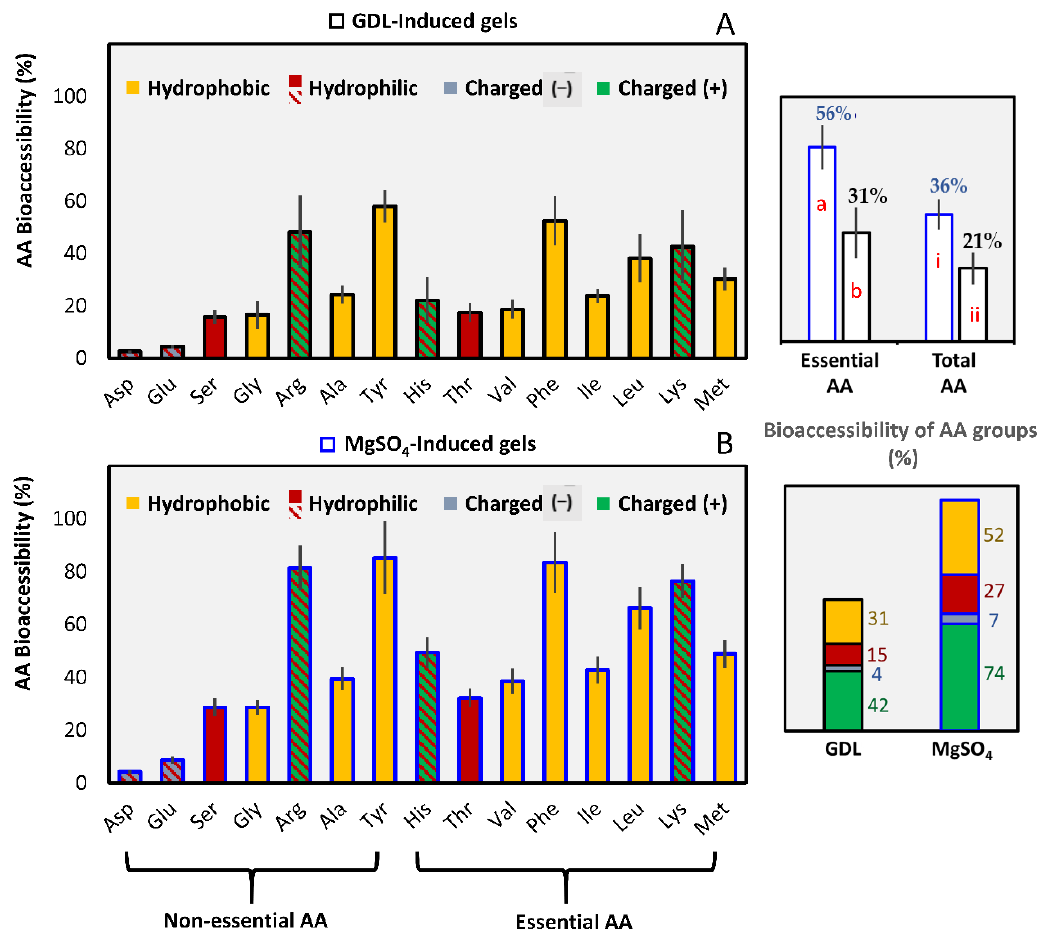
Figure 5. Bioaccessibility (%) of total, individual, and grouped amino acids at the end of the intestinal processing of the control pressed gels. The black frame around the bars correspond to GDL-induced gels ( A ) and the blue to MgSO 4 -induced gels ( B ). Amino acids were grouped according to Petsko and Ringe [65] and Damodaran et al. [66]. The values were represented as means ± standard deviations ( n ≥ 3). Different letters (a, b) indicate a significant difference among essential AA and different Roman numerals indicate a significant difference between total AA ( p ≤